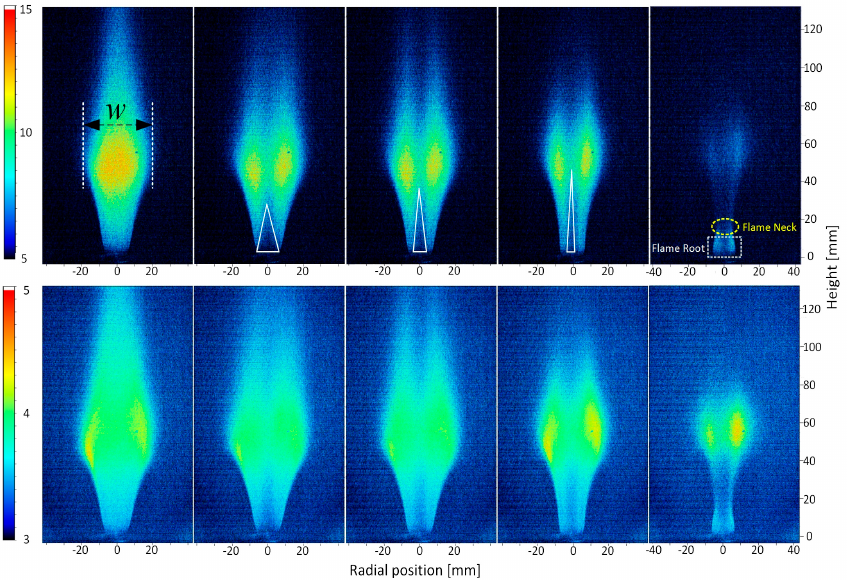
Figure 5. Time-averaged ( upper row ) and root mean square (RMS) ( lower row ) images of the flame structures with a central air jet (from left to right: U a /U c = 0, 0.79, 3.94, 7.87 and 13.22). An increase in the velocity of the central air jet shortened the annular premixed flame; release zone shrank, with the increase in the velocity of the central air jet. It was caused by the overall